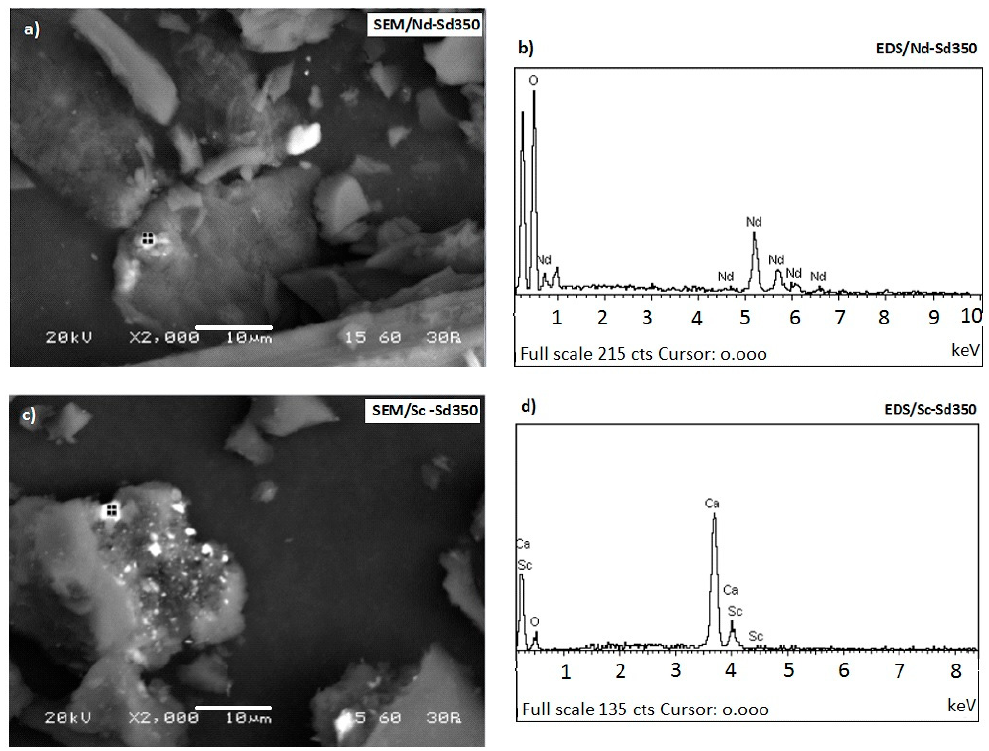
Figure 7. SEM micrographs at 2000× and corresponding EDS spectra of Sd350 biochar after Nd ( a , b ) and Sc ( c , d ) adsorption, respectively.